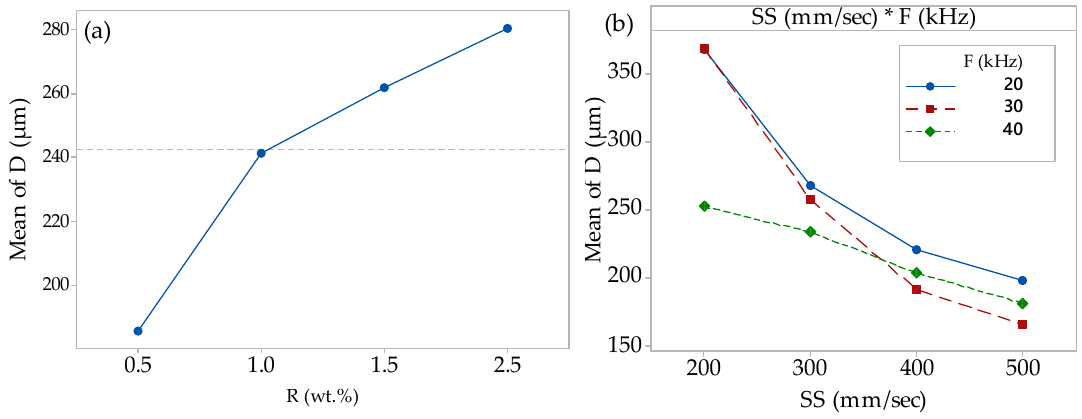
Figure 6. ( a ) Main effects for D, ( b ) interaction plot for D. (Note: × = * in all Figures).